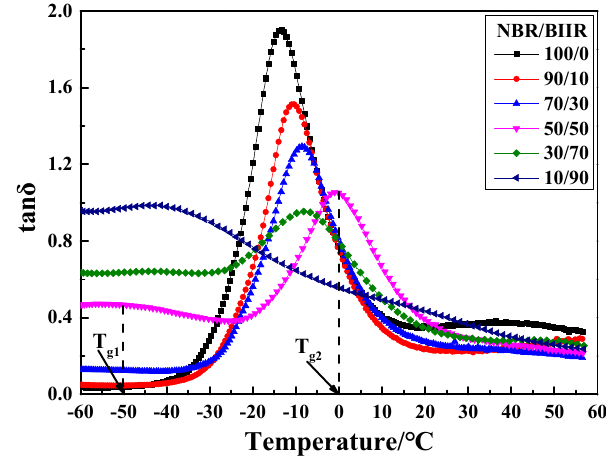
Figure 8 . Damping properties versus temperature for NBR/BIIR with various blend ratios.